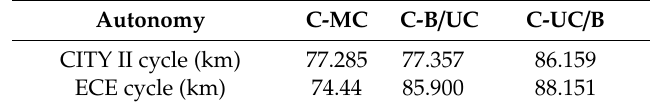
Table 5. Autonomy of the di ff erent configurations before driving cycles.